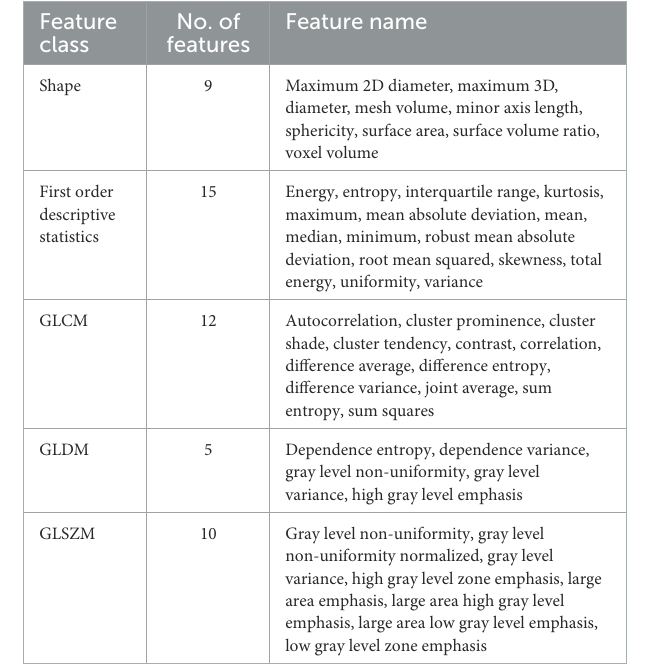
5 × 5 voxels in a one-voxel stride sliding. The batch